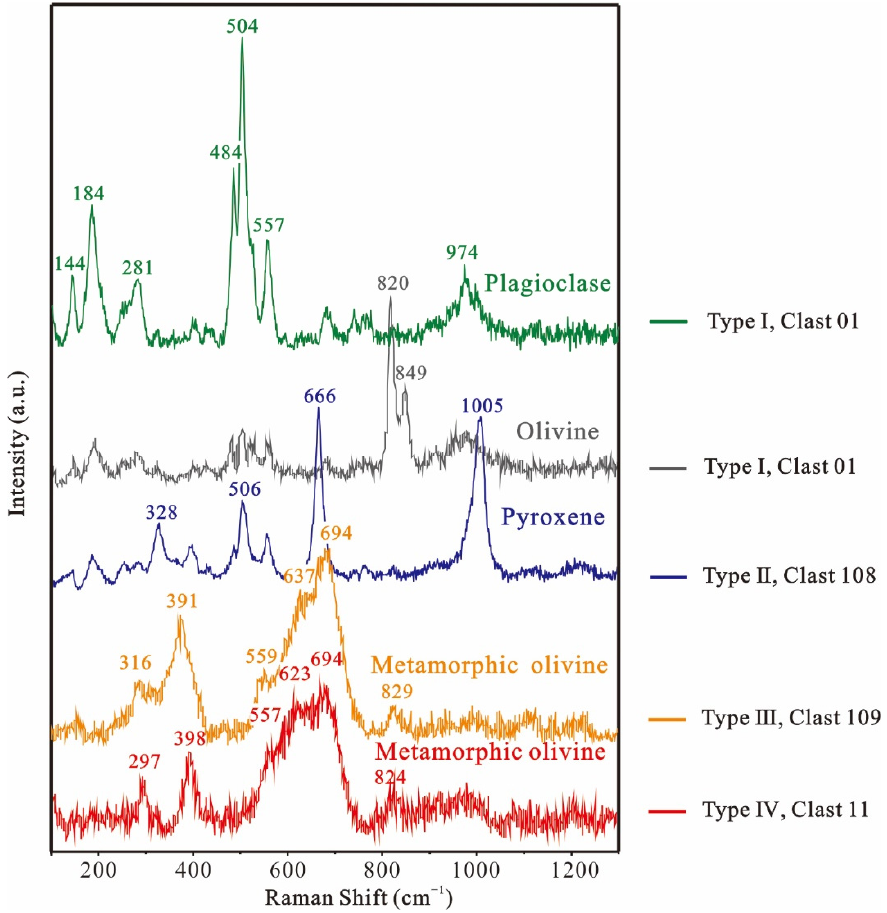
Figure 3. Raman spectra of minerals in different types of crystalline impact melt clasts. Green: Plagioclase microcrystals in plagioclase fragments in first type of clast (No. 01). Gray: Olivine with poikilitic-like texture in the first type of clast (No. 01). Blue: zoned pyroxene in the second type of clast (No. 108). Orange: Metamorphic olivine in the third type of clast (No. 109). Red: Metamorphic olivine in the fourth type of clast (No. 11).